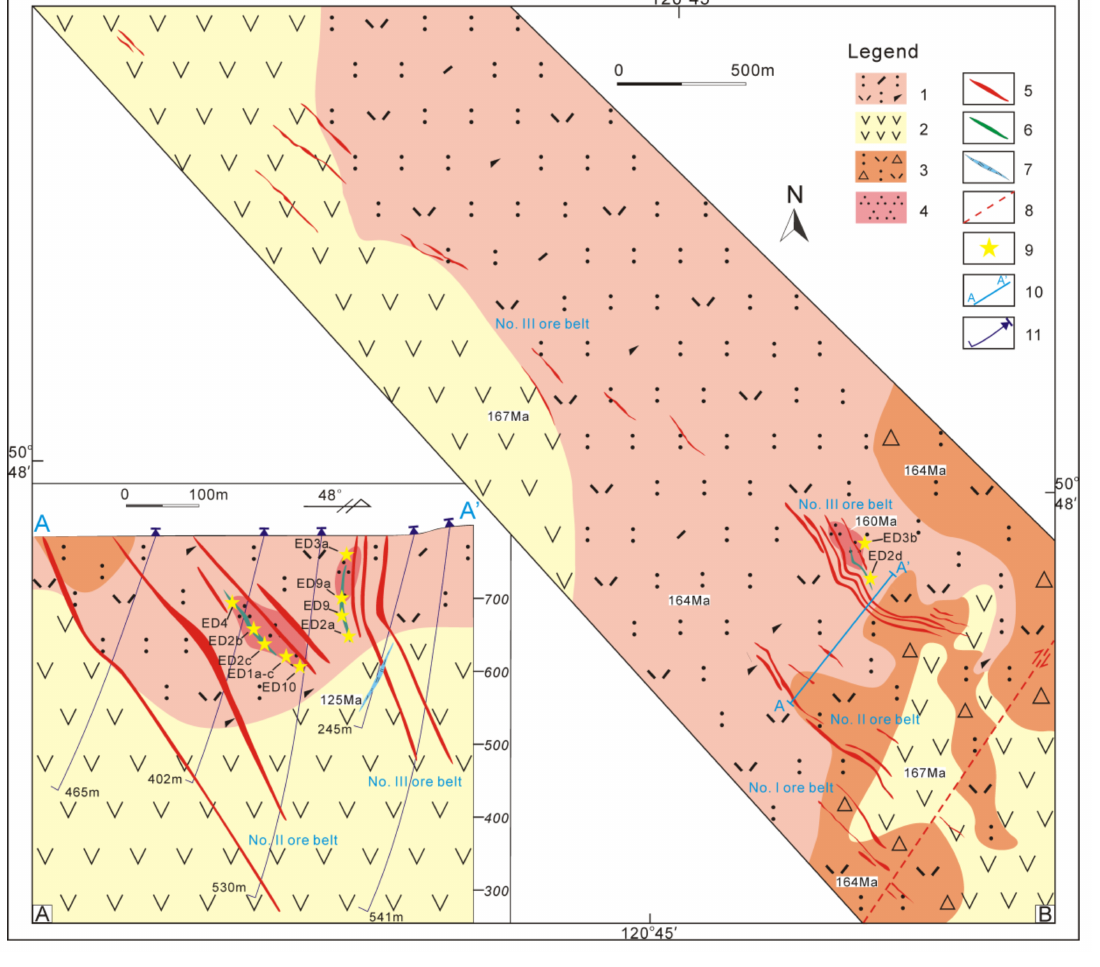
Figure 2. ( A ) Geological section of the Erdaohezi deposit. ( B ) Geological map of the Erdaohezi mining area [22]. 1. Rhyolitic crystal–lithic tu ff s; 2. breccia; 3. volcanic rocks of the Tamulangou